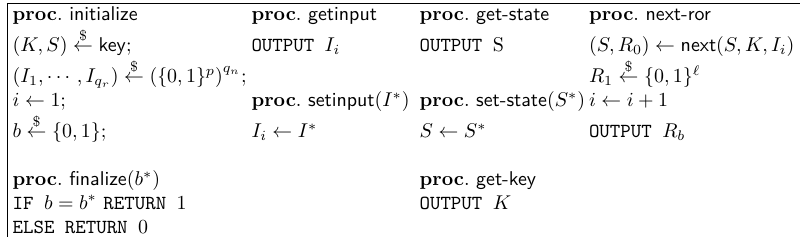
Figure 10: Procedures in Security Games CIA , CSA and